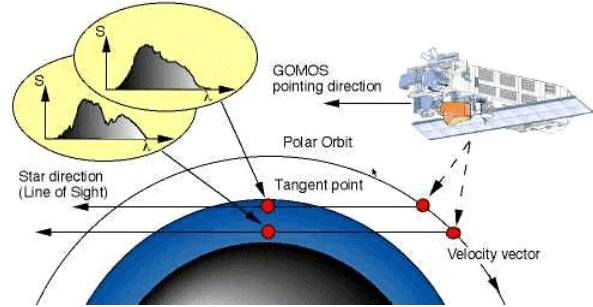
Fig. 1: The GOMOS principle of measurement by occultation of a star. The spectrum of a star is first measured outside of the atmosphere, then through the atmosphere; the ratio of the two spectra is the atmospheric transmission in this spherical geometry, at altitude z.